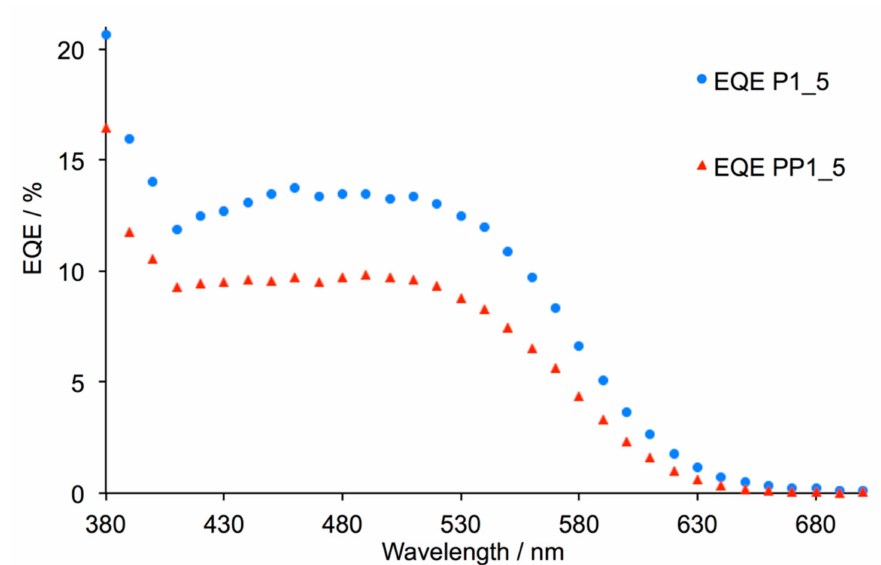
Figure 7. External quantum efficiency (EQE) spectra for DSCs with dyes P1 and PP1 (for each, cell 5